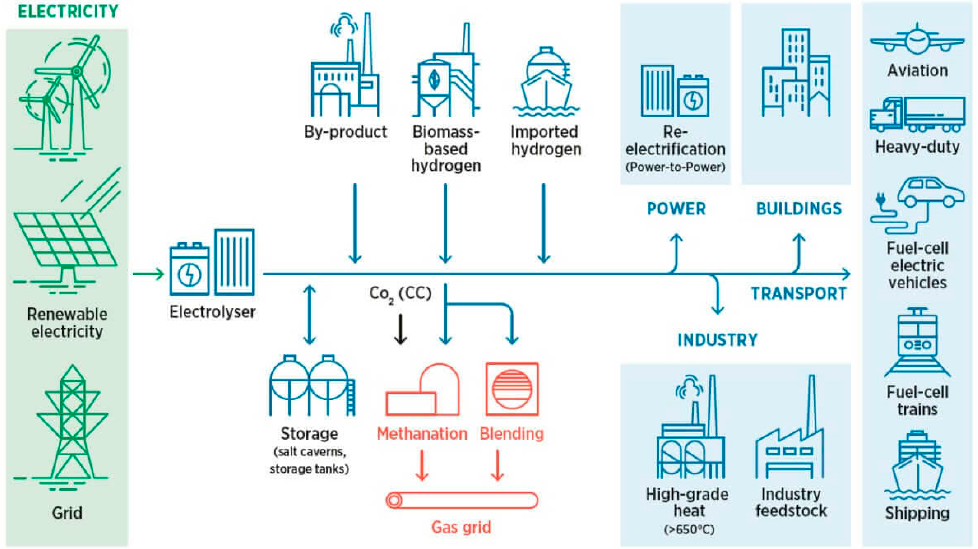
Figure 13. Different hydrogen sources and potential hydrogen applications [54].